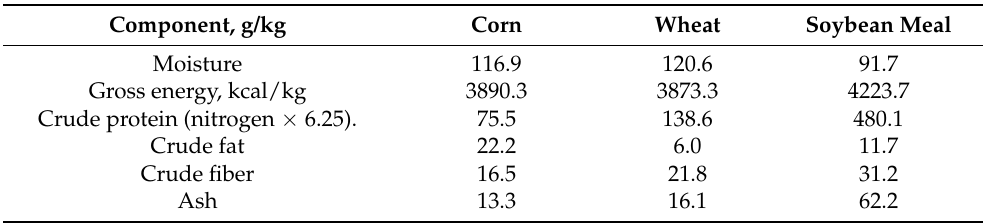
Table 2. Analyzed proximate composition of the major energy yielding feed ingredients contained in the experimental diets (on as-is